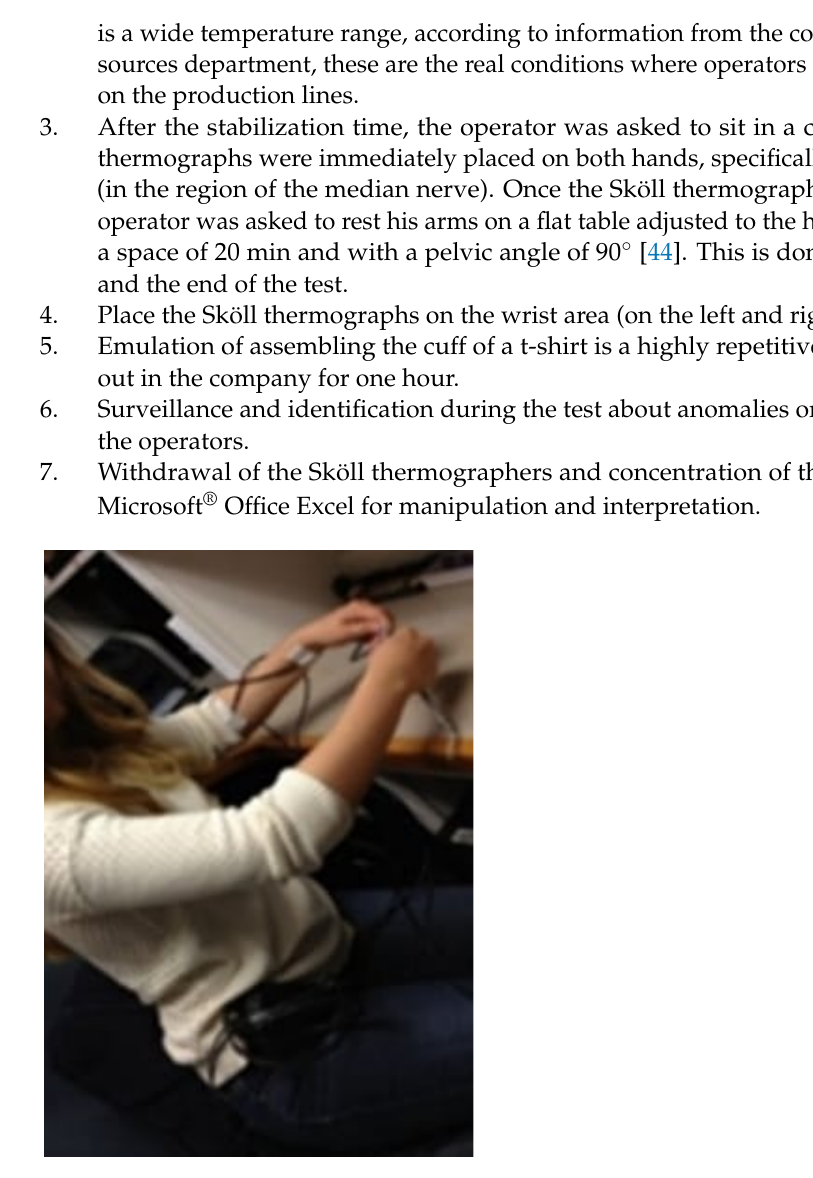
Figure 1. Sensory thermography, the procedure to carry out the tests with sensory thermography, placed the sensors in the wrist and elbow.